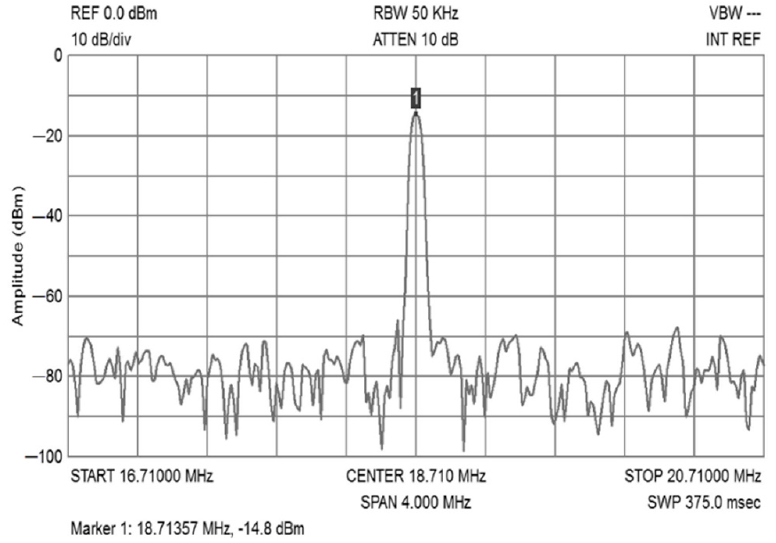
Figure 29. The output spectrum of the prototype oscillator with multiple-output improved Wilson current mirror ( m = 1).